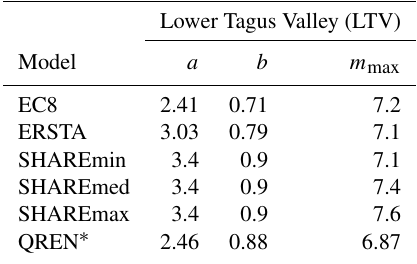
Table 1. Earthquake recurrence parameters ( a , b , m max ) for the Lower Tagus Valley (LTV) source zone from four of the models investigated. a and b are constants, and m max represents the maxi- mum magnitude.